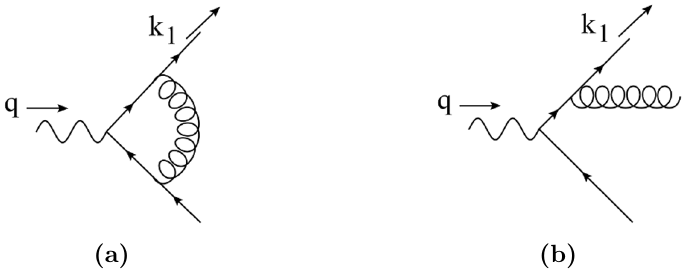
, when the emitted gluon is virtual (a) f